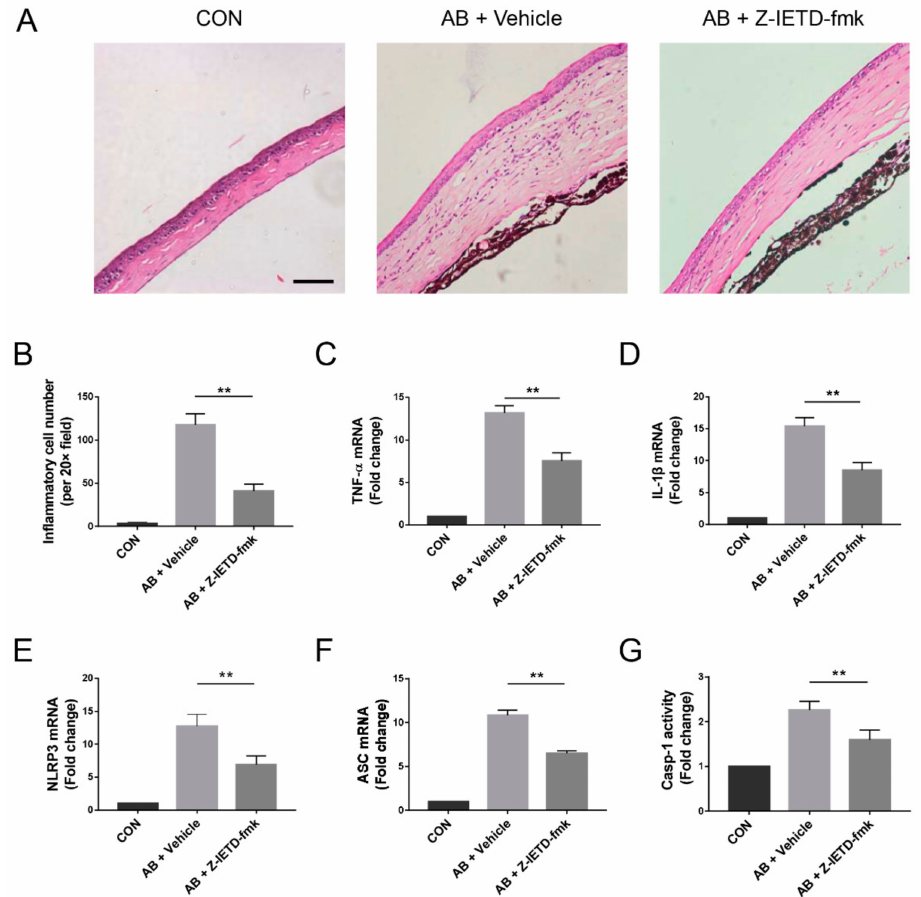
Figure 4. Pharmacological inhibition of caspase-8 suppressed alkali-induced inflammation and NLRP3 inflammasome activation. ( A ) Representative H&E staining of the eye tissue from di ff erent groups (20 × field). Scale bars: 100 µ m. ( B ) Histological analysis of inflammatory cell infiltration per 20 × field (n = 5). ( C – F ) RT-qPCR analysis of TNF- α , IL-1 β , NLRP3, and ASC mRNA expression in corneas ( n = 3). ( G ) Colorimetric assay of caspase-1 activity in corneas ( n = 3). The data are presented as the mean ± SD. ** p <